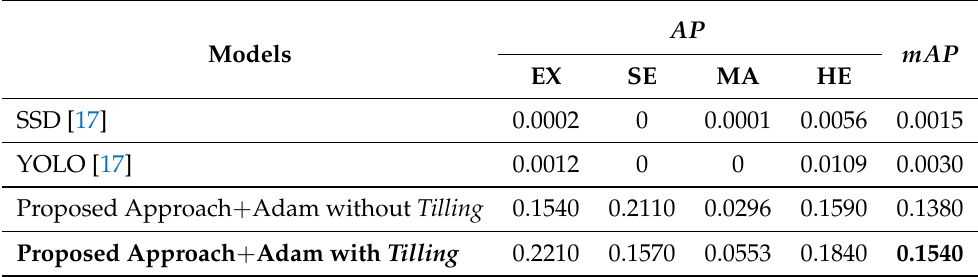
Table 7. Results obtained by the proposed approach with Adam optimizer compared to works related to the AP and mAP metrics for the Intersection over Union limit of 0.5 in the test set of the DDR (Dataset for Diabetic Retinopathy).